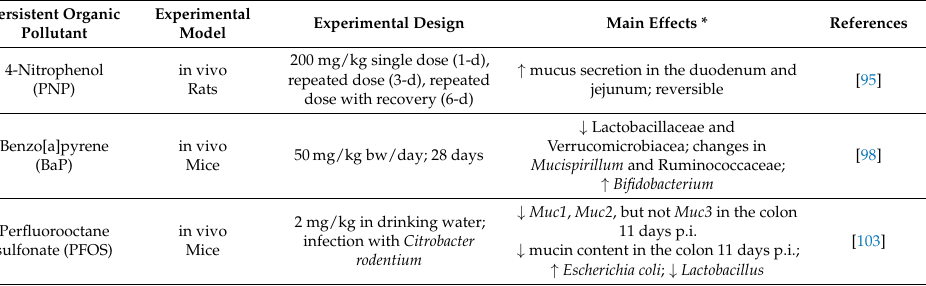
Table 3. Effects of persistent organic pollutants on mucus and mucophilic bacteria in the